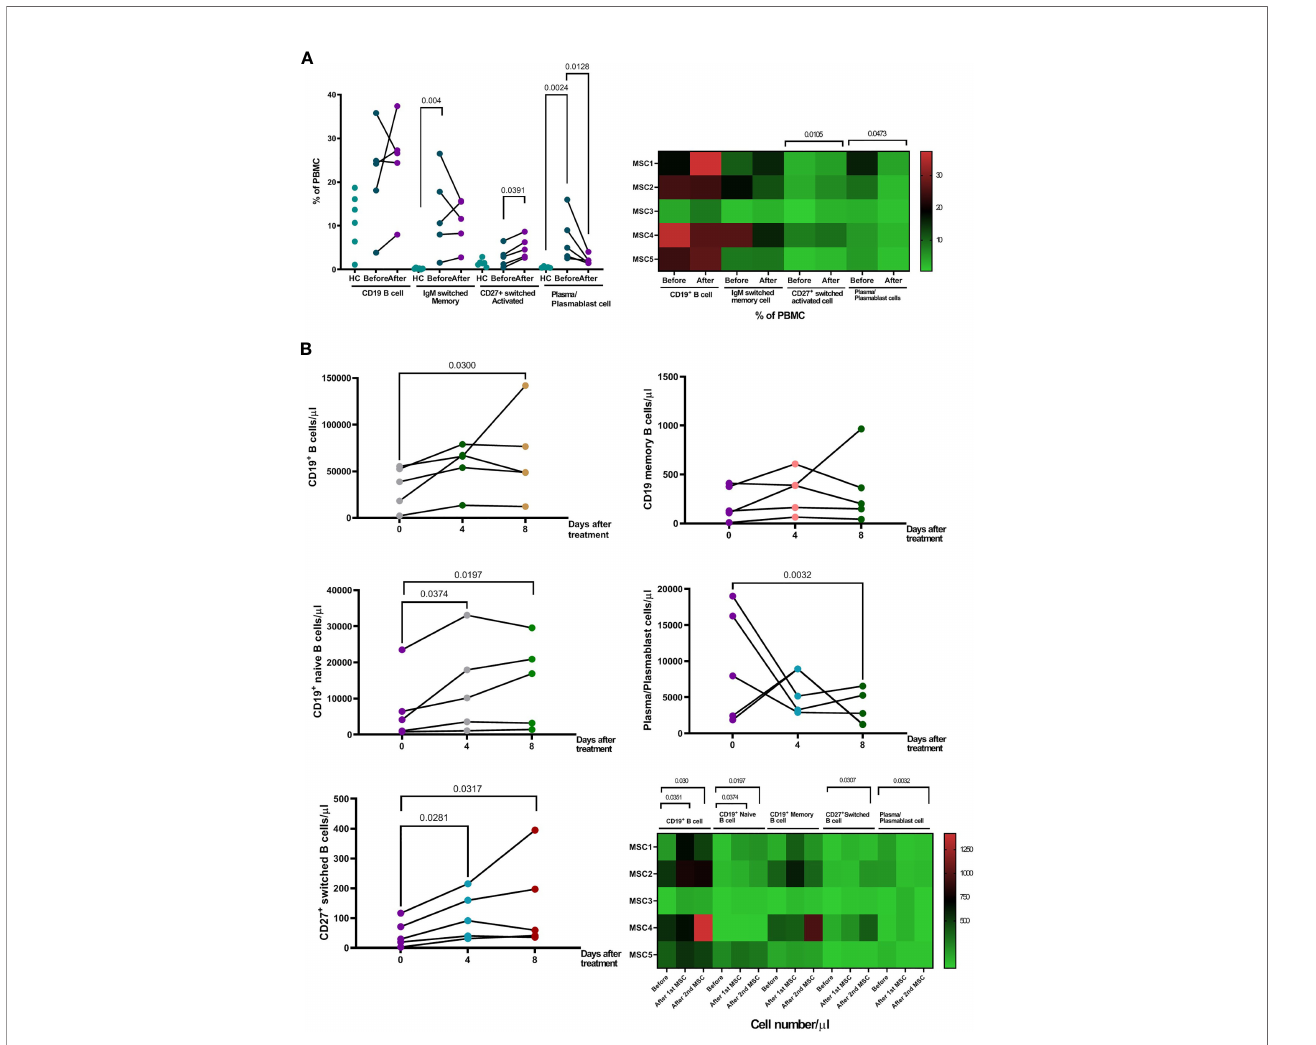
FIGURE 5 | Changes of B cell populations after pcMSC treatment. (A) High proportion of IgM + switched memory B cells and CD27 + CD38 + plasma/plasmablast cells in the peripheral blood, compared to healthy controls, before and after treatment. Treatment with pcMSCs increased the proportions of CD27 + switched activated B cell and decreased proportion of plasma/plasmablast cells. (B) The absolute number of B cells, CD19 + total B cell count, CD19 + Naïve B cells count, and CD27 + switched B cell were signi fi cantly increased after D4 and D8 of treatment. The absolute number of Plasma/Plasmablast cell was signi fi cantly reduced after Day 8 of treatment. The P value was as indicated. Nonparametric Wilcoxon sign-rank